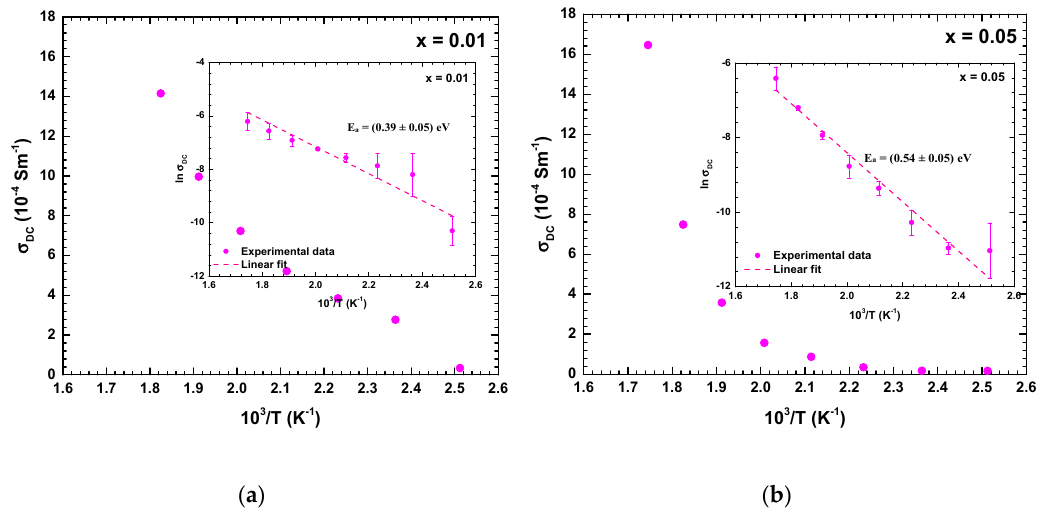
Figure 10. DC conductivity, σ DC , of LaFe 1 − x Zr x O 3 with ( a ) x = 0.01 and ( b ) x = 0.05 annealed at 800 ◦ C for 6 h at different temperatures.